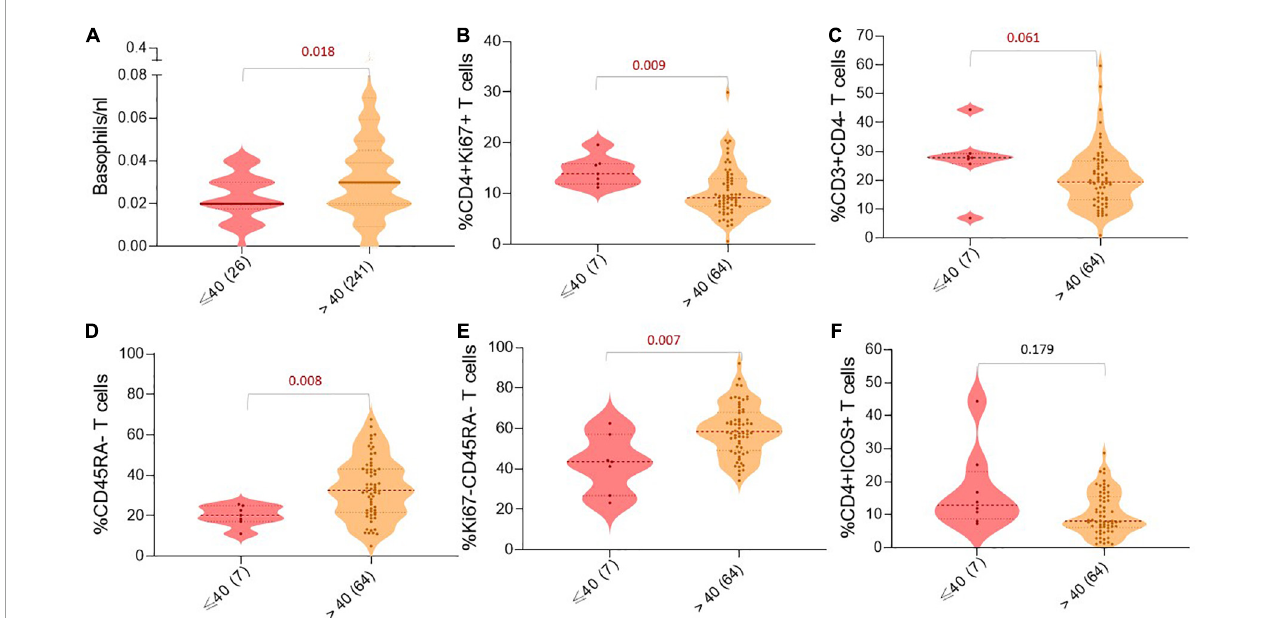
FIGURE2 Age-dependent differences in peripheral immune cell populations. Violin charts showing the number/frequency of immune cells in the patient’s blood based on age groups: (A) Basophils/nl, (B) %CD4 + Ki67 + T cells, (C) %CD3 + CD4-T cells, (D) %CD45RA-T cells, (E) %Ki67-CD45RA-T cells, and (F) %CD4 + ICOS + T cells. For all charts, the thick horizontal line and the thin dotted lines represent the 95% CI, respectively. The width of the curved shape indicates the proportion of patients in the group. P -values are presented above the respective immune cell subset.